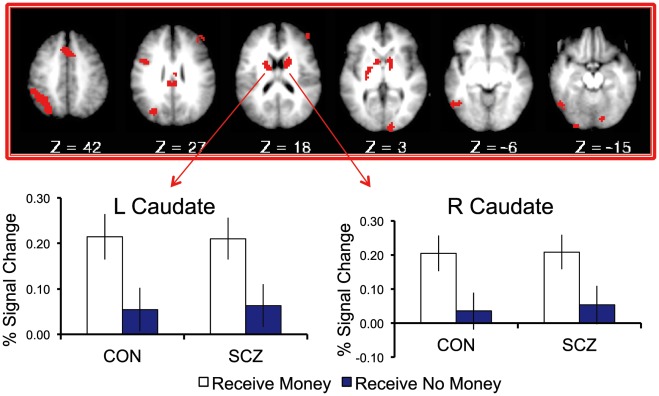
Regions demonstrating a significant main effect of receipt.All regions showed greater activation for receipt of money than no money. Both ROI results (threshold of p<.01 and 19 voxels within ROI mask) and whole-brain results (threshold of p<.003 and 13 voxels) are displayed. Graphs represent mean activation magnitudes across voxels within example regions among individuals with schizophrenia (SCZ) and controls (CON). Error bars represent standard error.